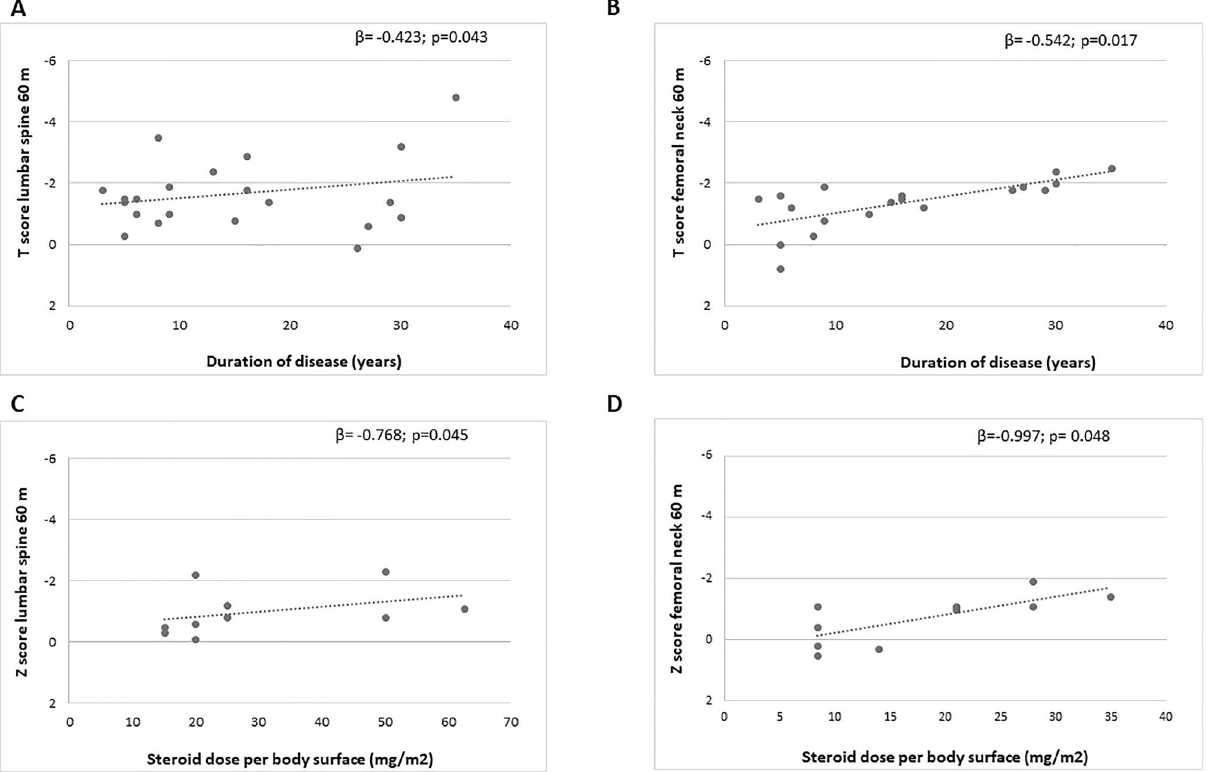
Figure 2. ( A ) Correlation between T score at lumbar spine and duration of disease at 60 months of follow-up. ( B ) Correlation between T score at femoral neck and duration of disease at 60 months of follow-up. ( C ) Correlation between Z score at lumbar spine and steroid daily dose per body surface at 60 months of follow-up. ( D ) Correlation between Z score at femoral neck and steroid daily dose per body surface at 60 months of follow-up.